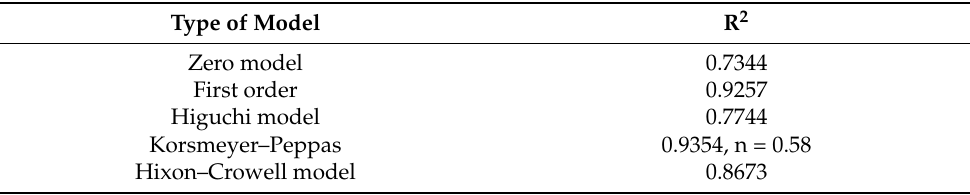
Table 4. Various kinetic release models and their regression value.